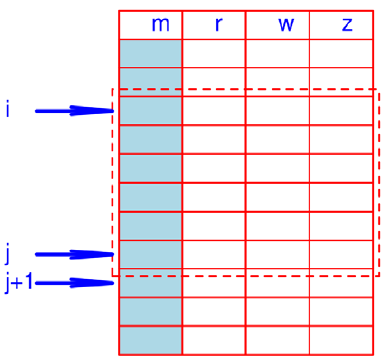
Figure 6. An illustration of constructing a M-cluster. The title line indicates the four fields of the string list; " m " stands for mass, " r " stands for retention time, " w " stands for map index, and " z " stands for feature intensity. The M-cluster starts from the i th string (row) and ends at the j th string (row). The dashed box indicates that the features (strings) within it form the M-cluster.